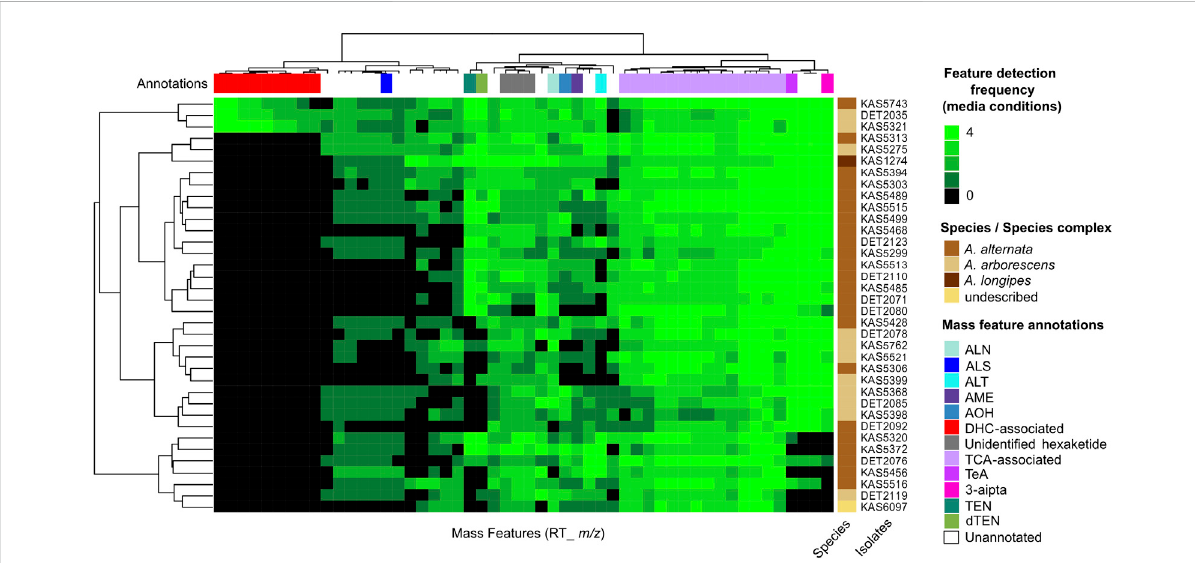
FIGURE 1 Untargeted metabolomics analysis of 36 Alternaria isolates, mainly from A. alternata and A. arborescens . Columns represent mass features, with heatmap values representing detection frequencies across four media conditions. Hierarchical cluster analysis was used to group isolates by the similarity of their mass feature detection frequencies (row dendrogram), and mass features by the similarity of their frequencies between isolates (column dendrogram). Annotations in the top colour bar are interpretations based on representative mass feature annotations: ALN, altersetin; ALS, altenusin; ALT, altenuene; AME, alternariol monomethyl ether; AOH, alternariol; DHC-associated, dehydrocurvularin and associated mass featuresannotated in this study; TCA, tricycloalternarene-associated mass features; TeA, tenuazonic acid-associated mass features; 3-aipta, 3-acetyl-5-isopropyltetramic acid; TEN, tentoxin; dTEN, dihydrotentoxin.